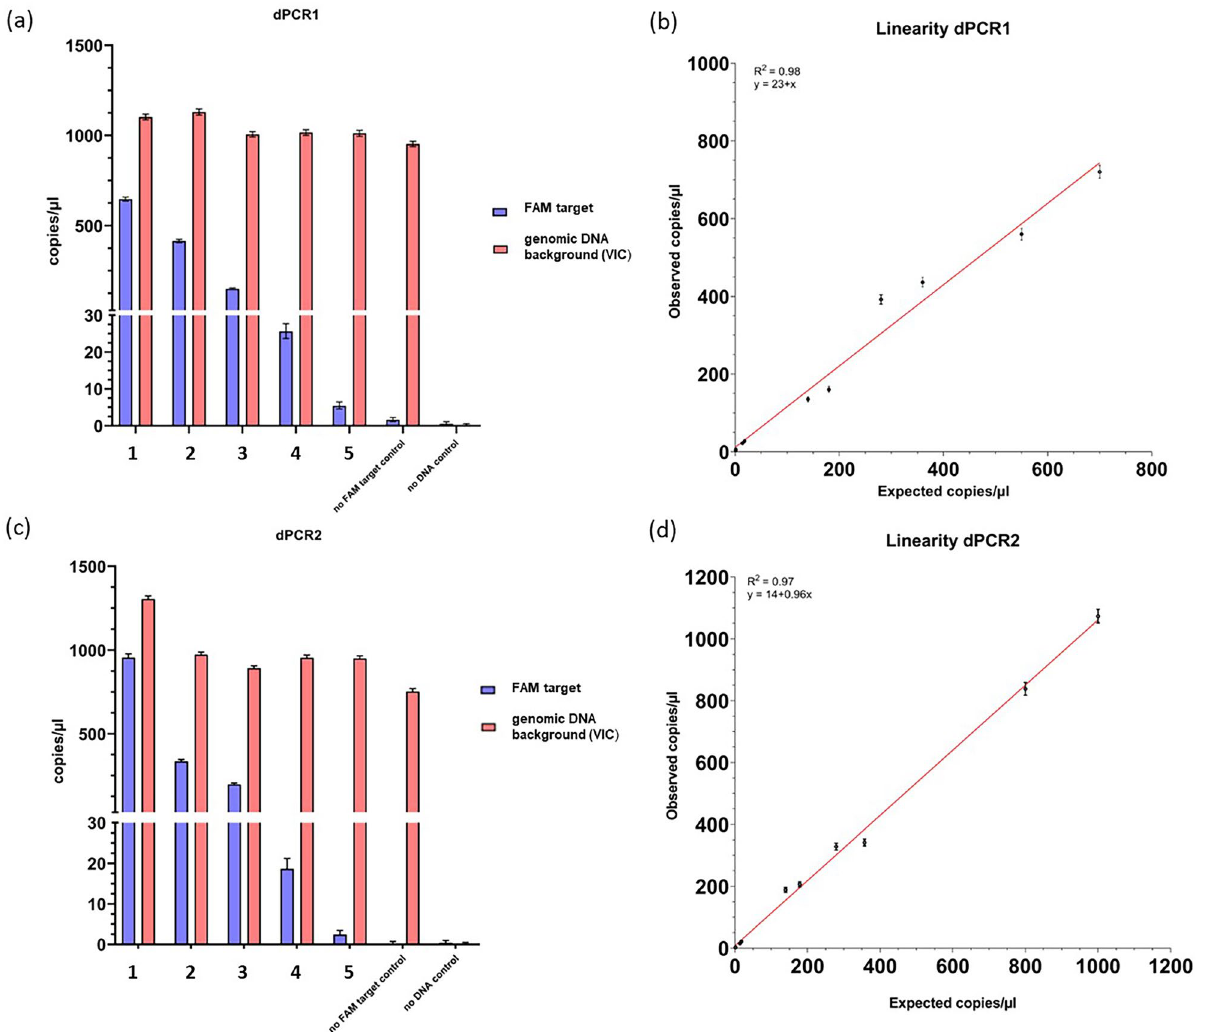
Figure 4. Quantitative nature of digital PCR1 and digital PCR2. Serial dilution of genomic DNA from two cell types: a knock-out single-cell clone ( a,b ) and homozygous-blue allele-bearing PGCs ( c,d ) at 650 to 5 copies/µl and 970 to 2 copies/µl per 14.5 µl reaction, respectively (FAM target). DNA was diluted in a constant background of genomic DNA (without FAM target) at 890 to 1300 copies/µl ( a,b ) and 990 to 1100 copies/µl ( c,d ) (VIC target). ( a ) Mean copies/µl of background genomic DNA (red bars) and diluted DNA (blue bars) for dPCR1, ( b,d ) expected and observed values of the dilution series (dPCR1 and dPCR2 results), data include two dilution series with different initial DNA concentrations. Error bars indicate 95% CI, ( b ) linearity of dPCR1 results, ( F 1,8 = 380.2, p < .001), ( c ) mean copies/µl of background genomic DNA (red bars) and diluted DNA (blue bars) for dPCR2, ( d ) linearity of dPCR2 results, ( F 1,8 = 239.5, p <